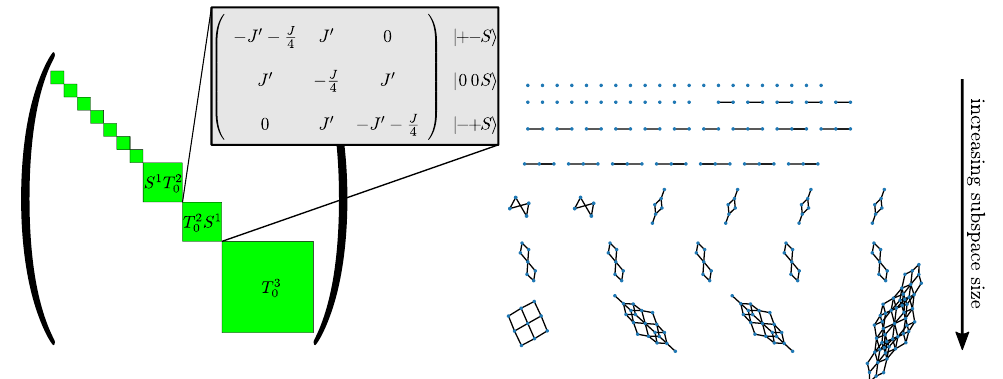
Figure 2: Top: The Hamiltonian structure for three rungs and full frustration ( δ = 0) = 0 sector, together with the labels of the largest blocks. The grey inset in the S z tot S in detail. shows the 3 × 3 matrix of the block T 2 0 Bottom: Connectivity graph of the Hamiltonian for L = 5 rungs. Each dot corre- sponds to a basis state in the rung singlet / triplet basis and the connections show the terms of the Hamiltonian. Disconnected subgraphs correspond to the Hilbert space fragments. The largest subgraph is the all triplet